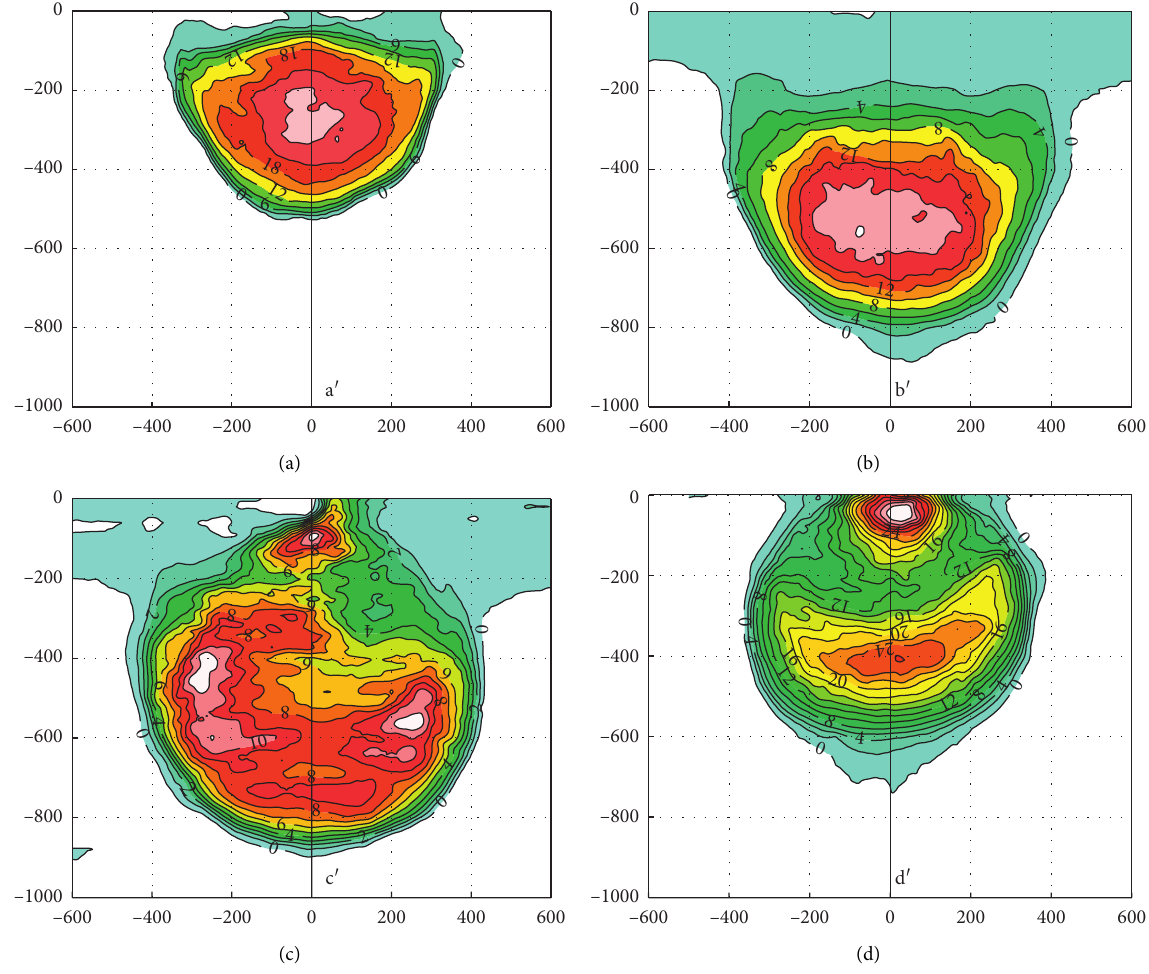
Figure 6: Contour map of flowslides topography at different slope angles: (a), (b), (c) and (d) corresponding to 40 ° , 50 ° 60 ° and 70 ° , respectively.